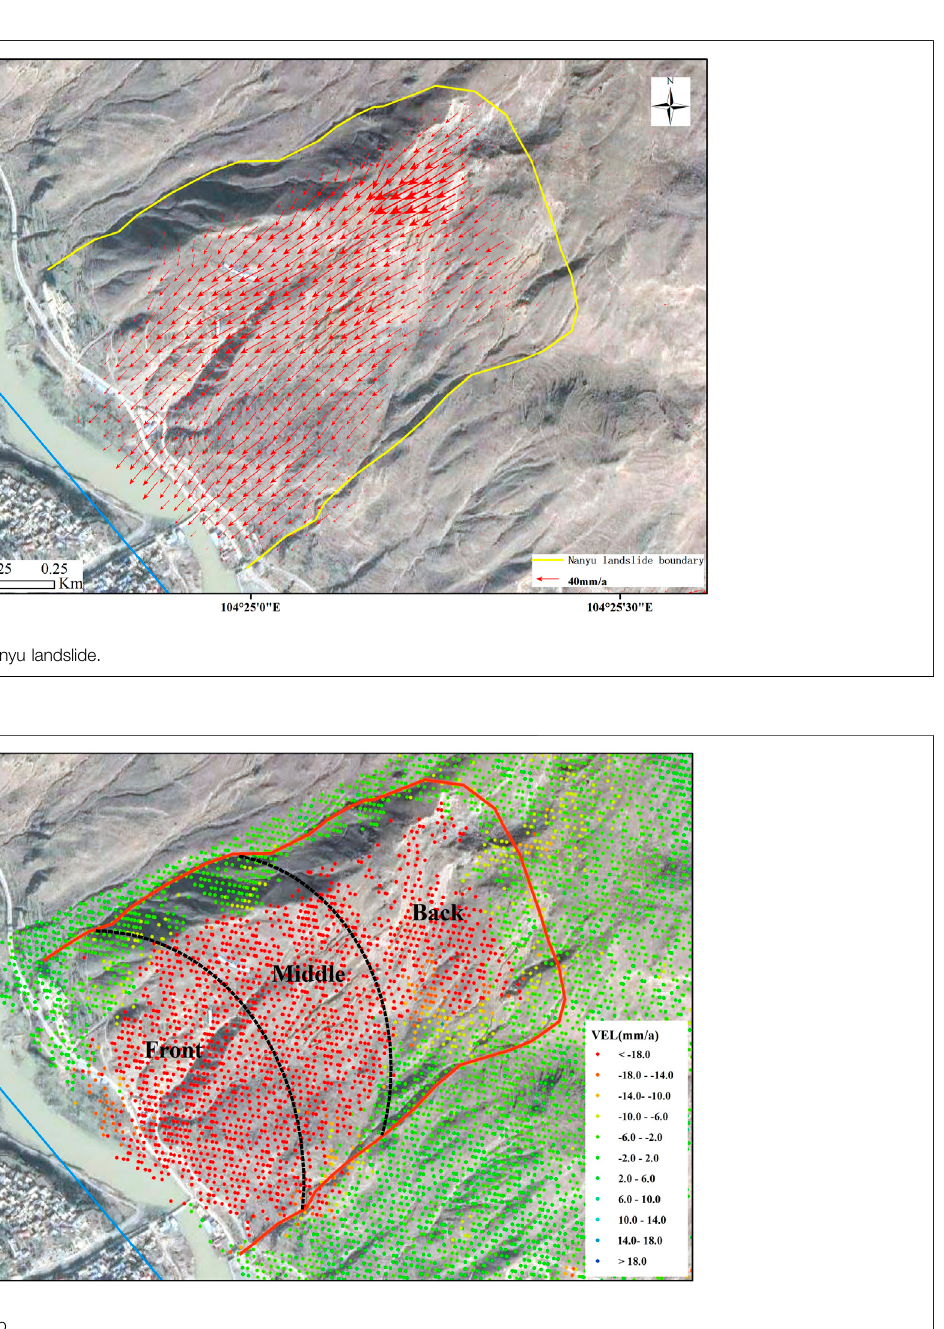
FIGURE 12 | Landslide body division